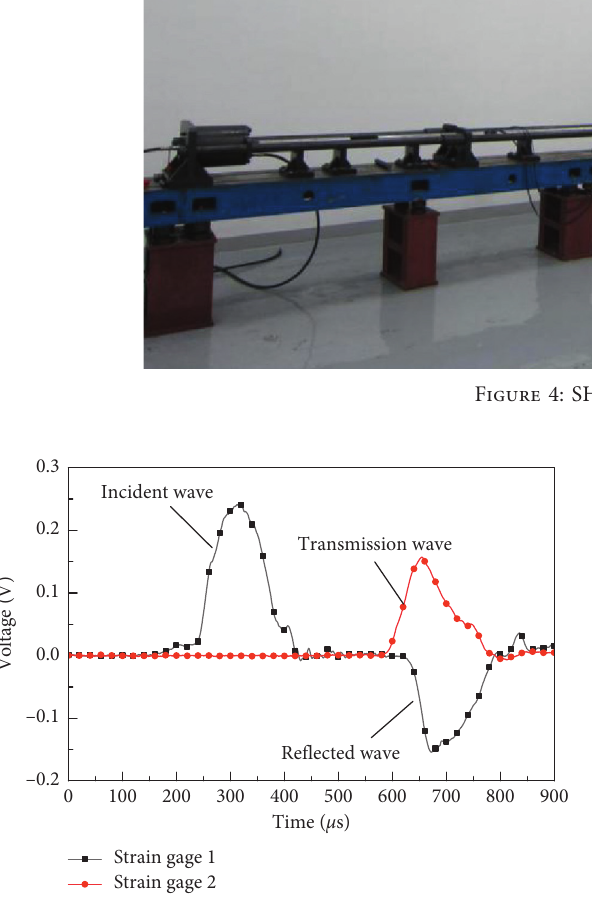
Figure 5: Measured strain signal in SHPB test of limestone